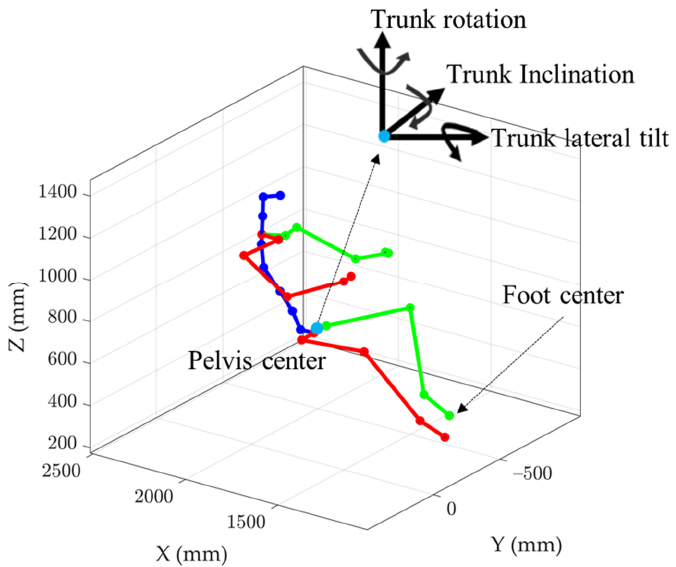
Figure 2. Driver posture after reconstruction using mocap data. A coordinate system located at the driver’s hip center was used to describe different trunk positions.